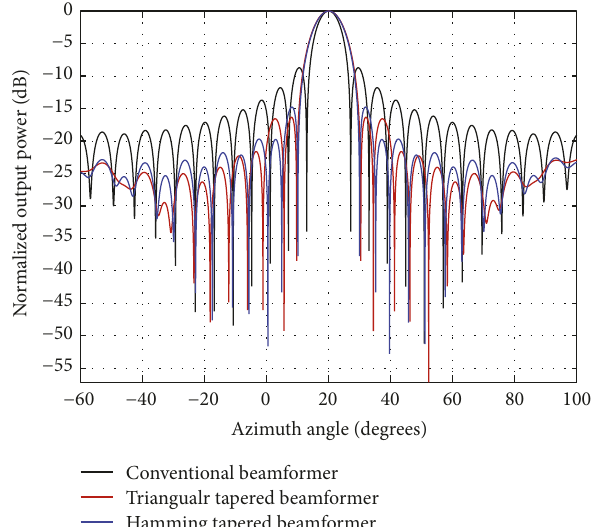
Figure 5: Normalized power pattern comparison of conventional CECCAA beamformer with tapered CECCAA beamformers.